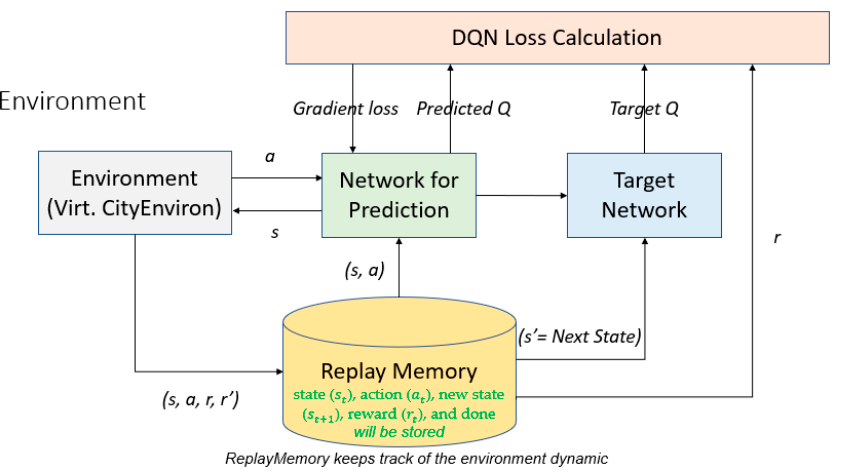
Figure 4. The data flow diagram for a DQN-network model with a responding buffer memory unit and a targeted network that is associated with a virtual environment